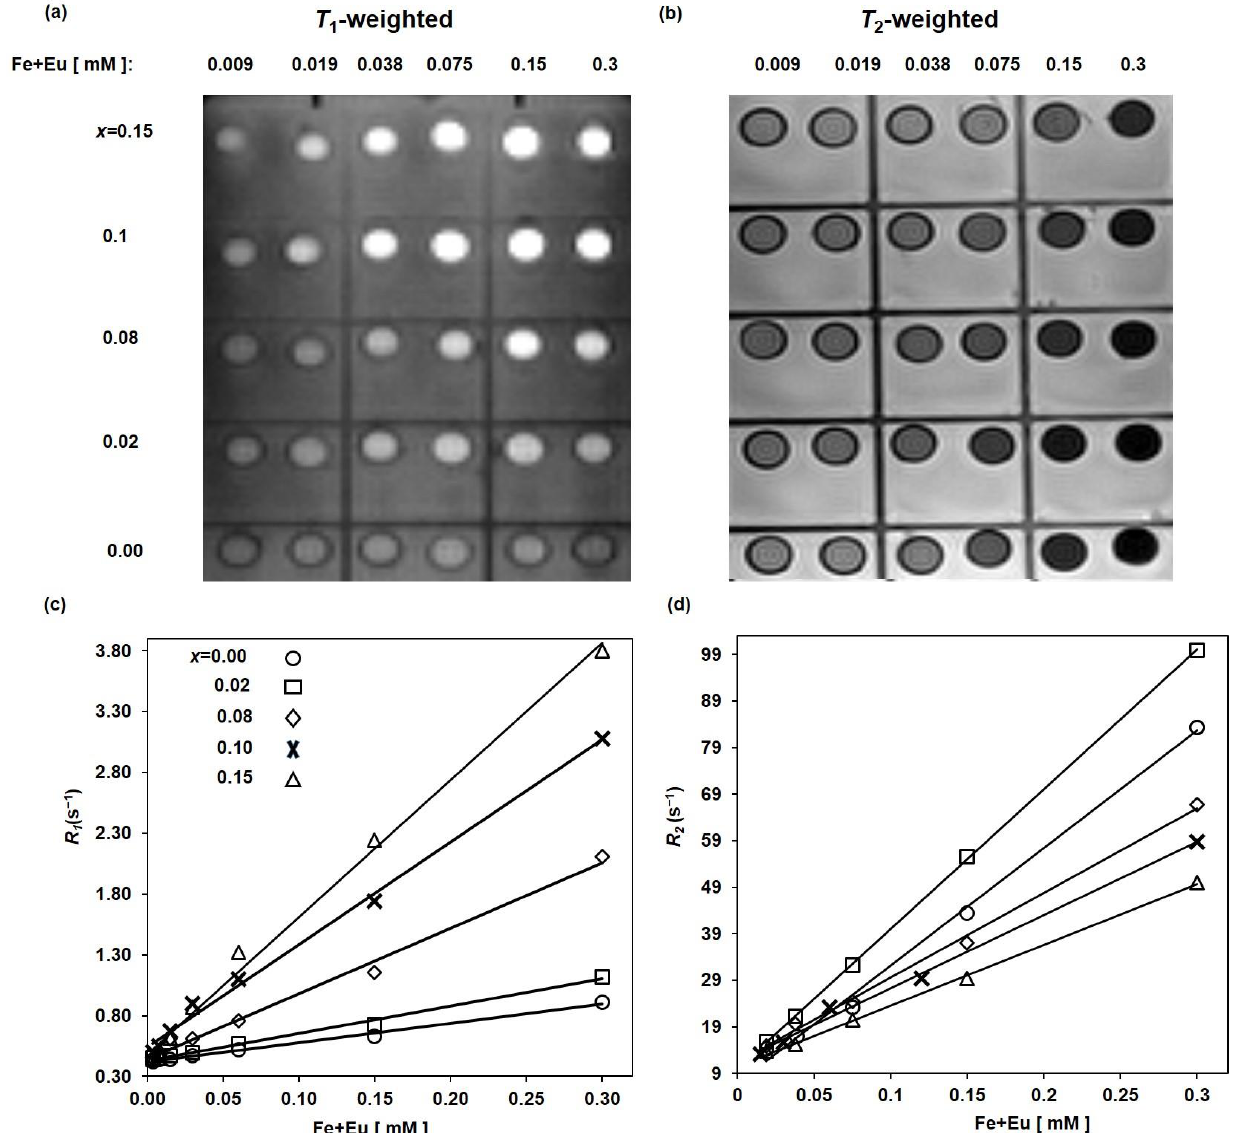
Figure 10. ( a ) T 1 -weighted MR images, ( b ) T 2 -weighted MR images, ( c ) longitudinal R 1 relaxation rate and ( d ) transverse R 2 relaxation rate as a function of concentration for Mn 0.6 Zn 0.4 Eu x Fe 2 − x O 4 ( x = 0, 0.02, 0.08, 0.1, 0.15). Table 2. Longitudinal r 1 and transverse r 2 relaxivities of EuMZF nanoparticles with different Eu substitutions.